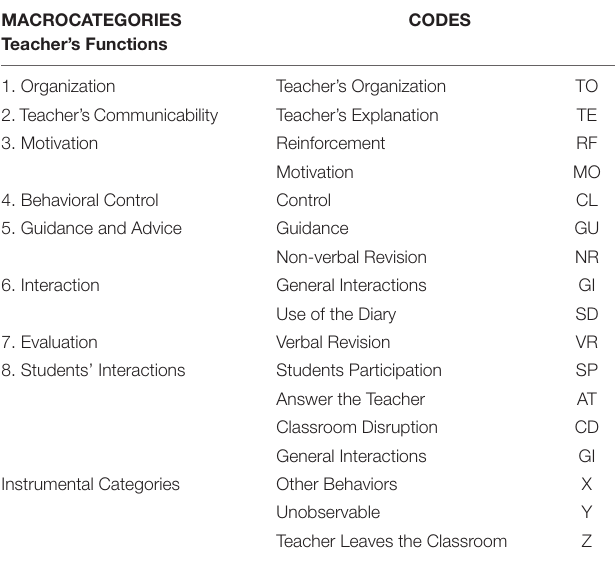
TABLE 2 | Observational protocol in the Teaching Functions in Primary School and Special Education (PROFUNDO-EPE, v.3., in Spanish). MACROCATEGORIES Teacher’s